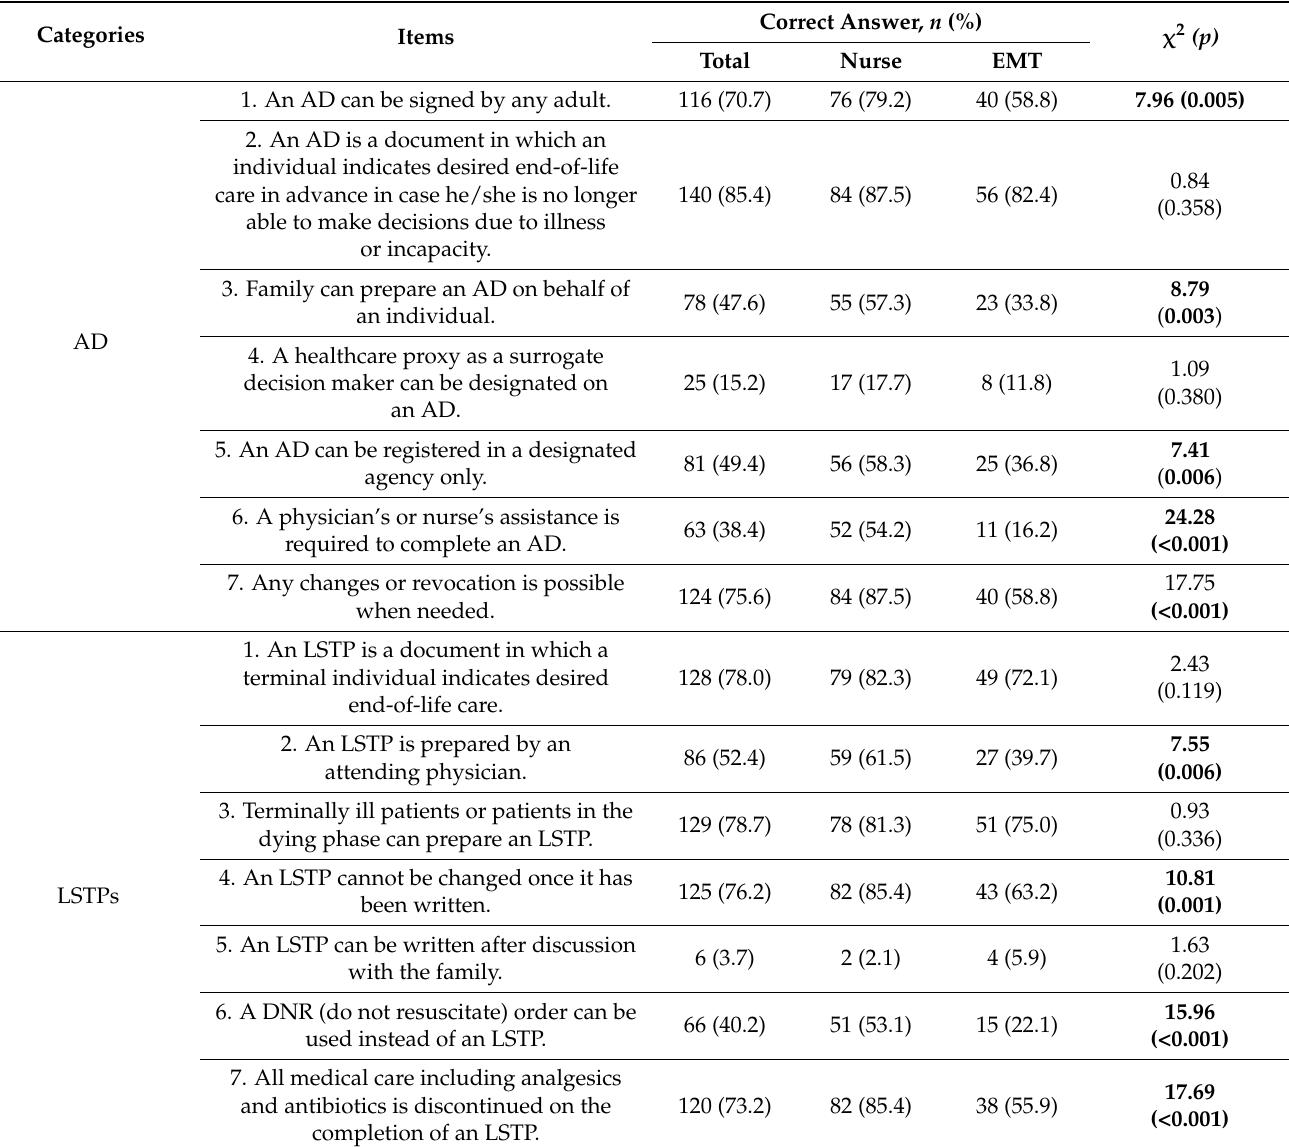
Table 2. Comparison of correct answer rate for specific knowledge about an AD on LSTs and LST plans between emergency nurses and emergency medical technicians ( n =